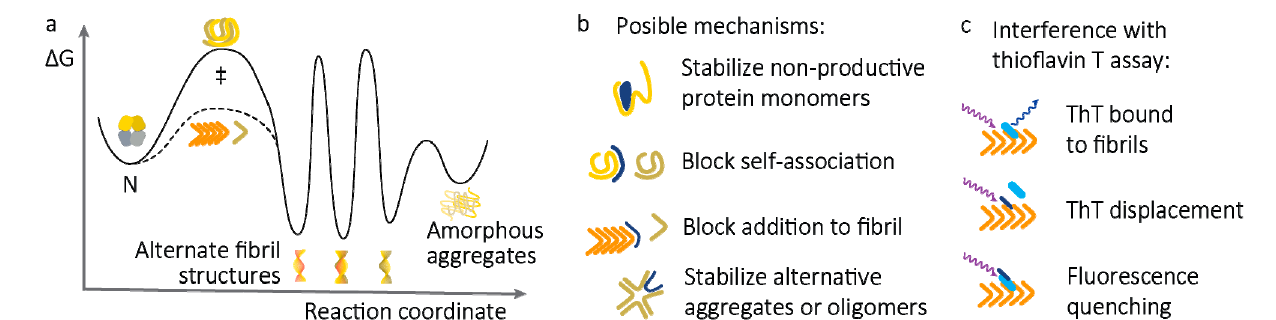
Figure 5. Schematic depiction of amyloid formation by non-native LCs. ( a ) The endpoint proportion of aggregated LCs is defined by the critical concentration, but the rate at which this reaction proceeds is determined by the self-association of amyloid-competent, non-native LCs, associated with the transition state ‡. The energy barrier associated with extension of fibrils (dashed line) is lower than that for nucleation of new fibrils. Multiple fibril or other aggregate structures may be accessible to the LCs, shown as distinct energy minima. However, the energy barriers to interconversion between these states are likely to be large, requiring dissociation, unfolding, and reaggregation of the subunit molecules. ( b ) Small molecules could inhibit amyloid formation (or enhance amyloid dissociation) via multiple mechanisms, depicted schematically. ( c ) Amyloid formation can be readily measured by binding of the fluorogenic dye thioflavin T (shown as a cyan bar), but small molecules (black bars) may interfere with this assay. Excitation and emission photons are shown as wavy arrows.